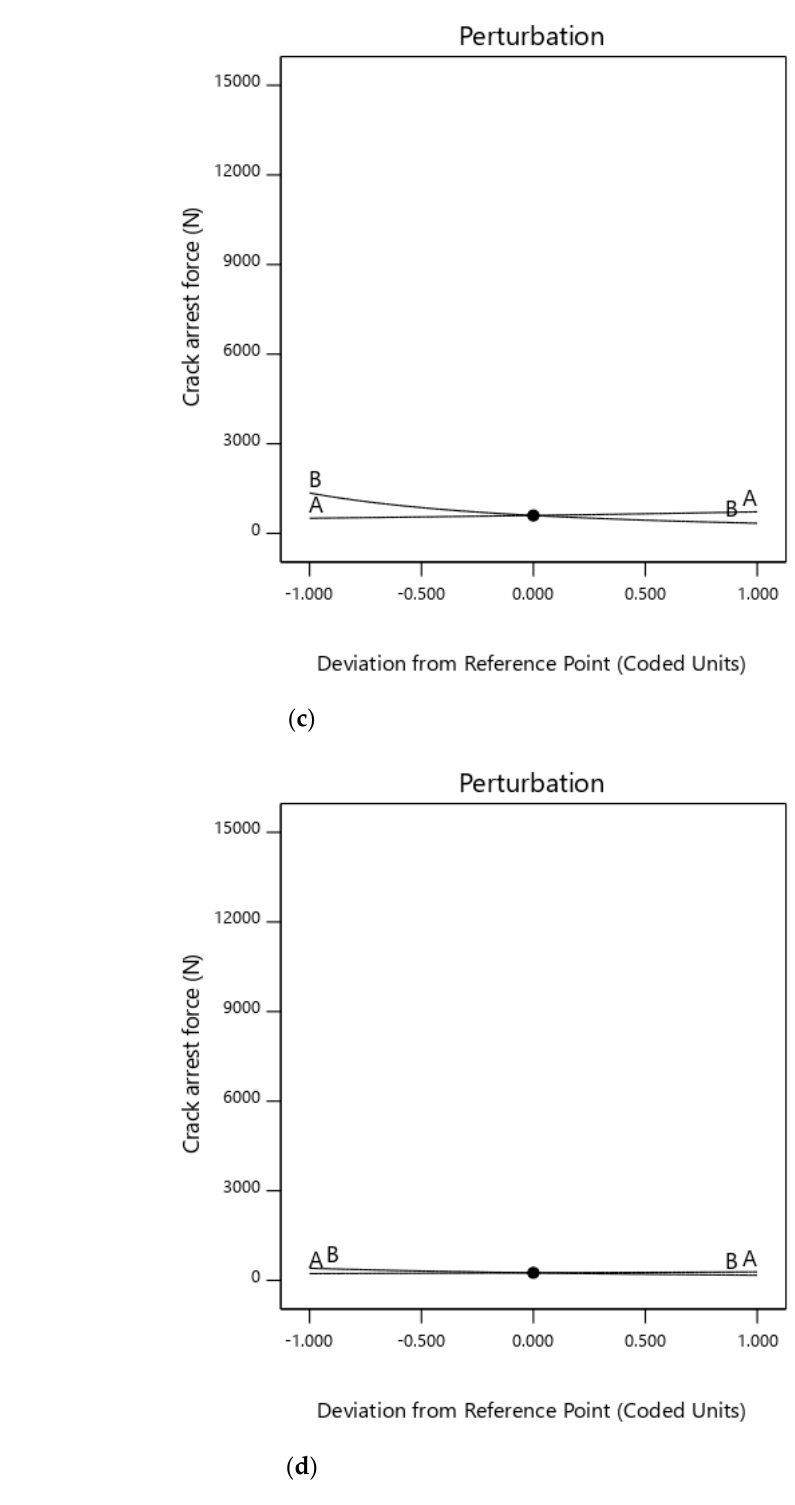
Figure 6. Process parameters on the crack arrest force. ( a ) The interaction between A-Hatch spacing and B-Interlayer rotation for the stripes strategy, ( b ) perturbation plot for the stripes build strategy, ( c ) perturbation plot for the chessboard strategy, and ( d ) perturbation plot for the hexagonal scanning strategy.